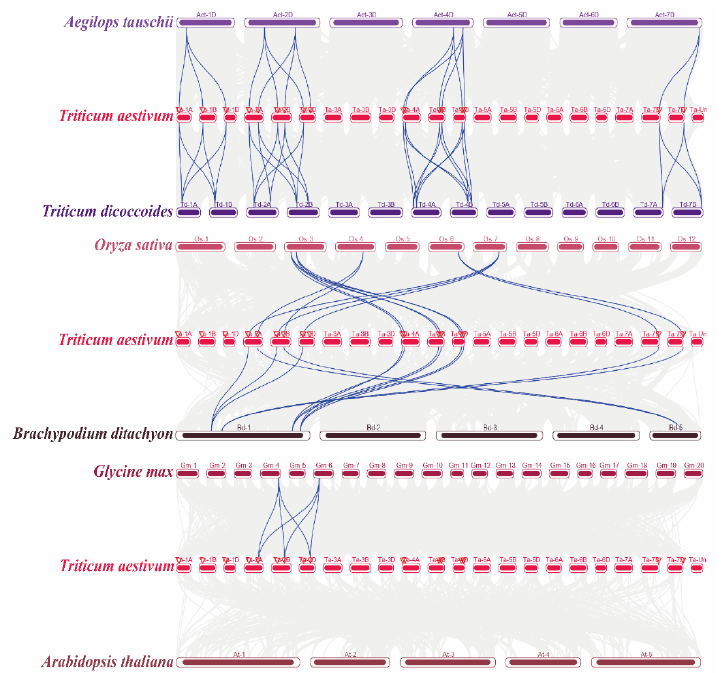
Figure 3. The syntenic relationship between ELPs of wheat and Oryza sativa, Arabidopsis, Brachypodium, Glycine max, Triticum dicoccoides , and Aegilops tauschii . Collinear blocks in wheat and other plant genomes are represented by gray lines in the background, while syntenic TaELP gene pairs are highlighted with blue lines.